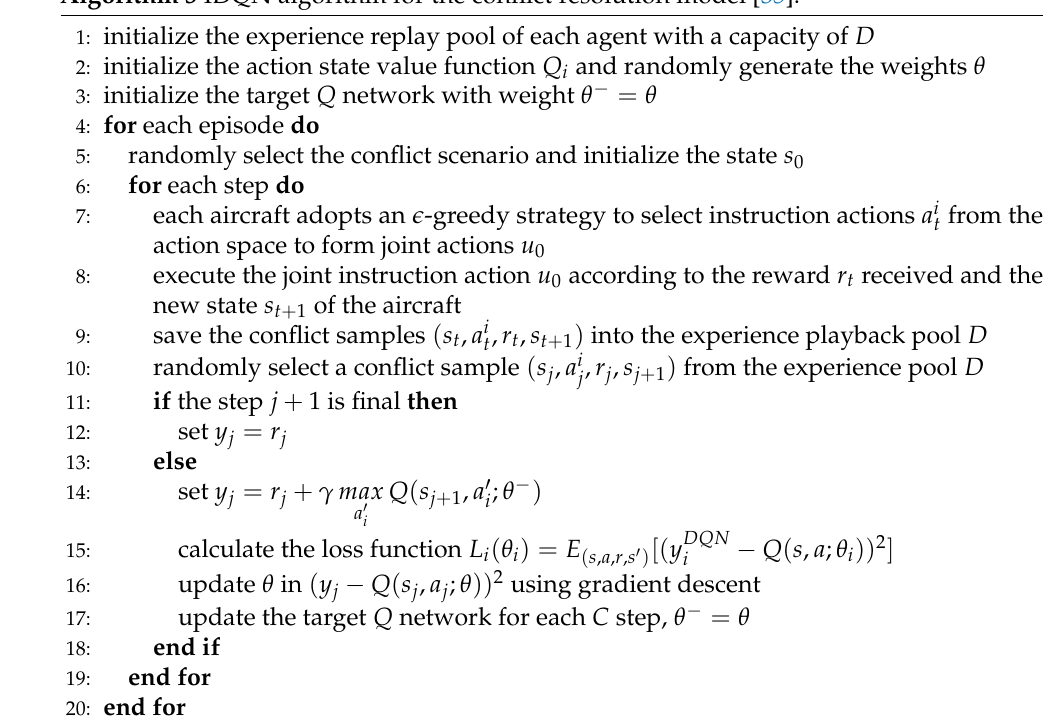
Algorithm 3 IDQN algorithm for the conflict resolution model